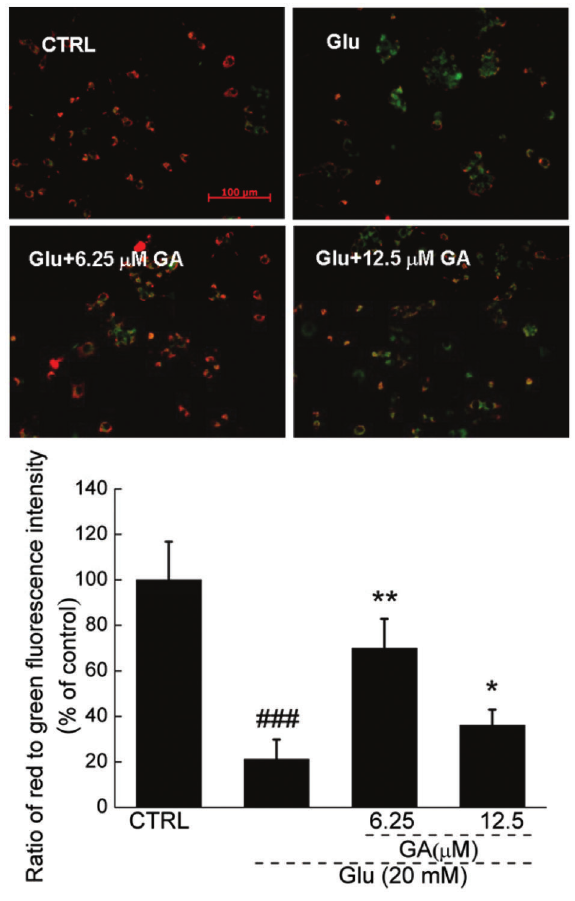
Figure 2. Glycyrrhizic acid (GA) restored glutamate-disturbed mitochondrial function (20 6 ; Scale bar: 100 m m). Differentiated PC12 cells were pretreated with 6.25 and 12.5 m M GA for 3 h and exposed to 20 mM glutamate (Glu) for 12 h. The changes of mitochondrial membrane potential (MMP) were determined by JC-1 staining. Red fluorescence indicates healthy cells with high MMP, whereas green fluorescence indicates apoptotic or unhealthy cells with low MMP. Average ratio of red (590 nm) to green (540 nm) fluorescent intensity of each cell in different groups was calculated (n=50) and data are reported as a percentage (means±SD) of that from corresponding control cells (CTRL). ### P , 0.001 vs CTRL; *P , 0.05 and **P , 0.01 vs Glu-treated cells (one-way ANOVA followed by Dunn 9 s